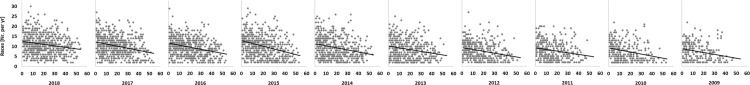
Correlation matrixes for number of races per year in regard to ranking at the 2018 European Long-Course Swimming Championships.Data points represent individual values for each participant and year across all swimming strokes and race distances.